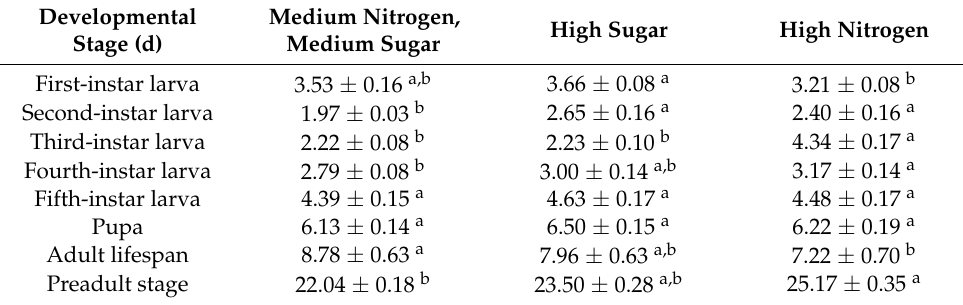
Table 1. Developmental duration of S. exigua under three nutritional conditions.